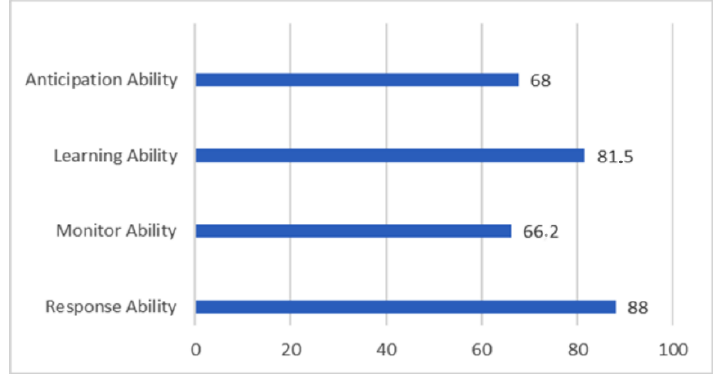
Figure 3. Average resilience safety level at the public company.